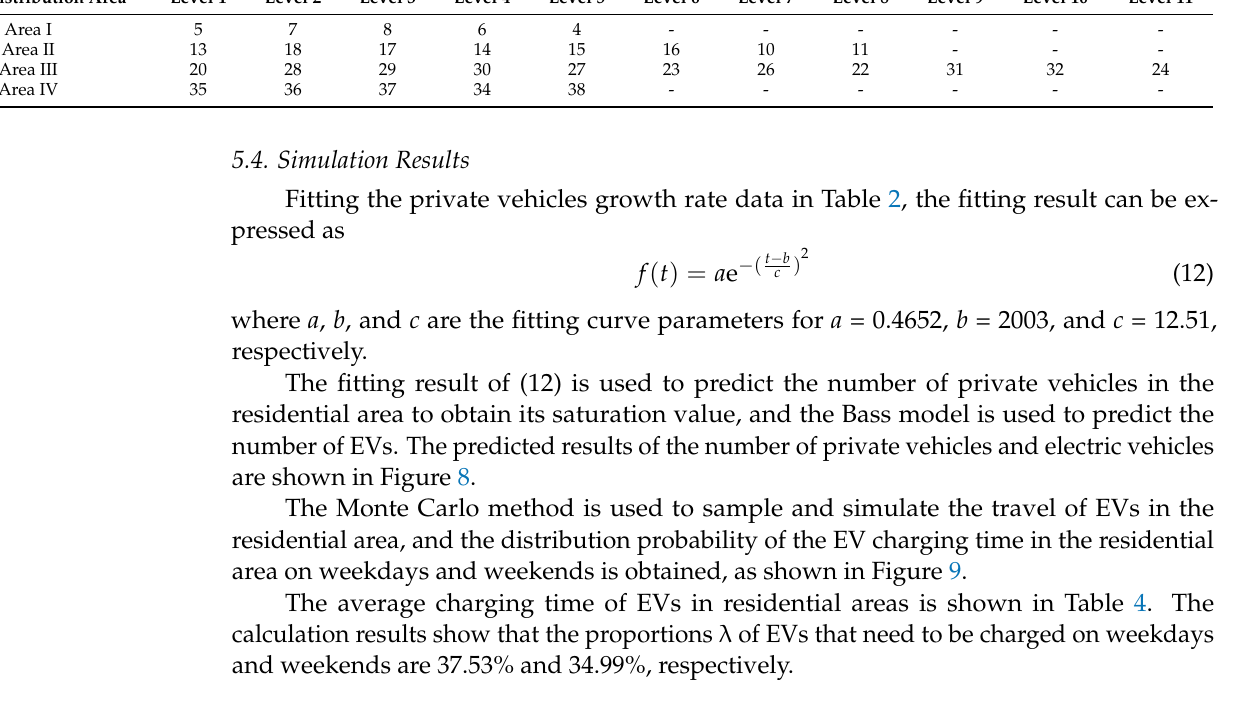
Figure 8. Private vehicles and EV ownership in residential areas. The Monte Carlo method is used to sample and simulate the travel of EVs in the residential area, and the distribution probability of the EV charging time in the residential area on weekdays and weekends is obtained, as shown in Figure 9.